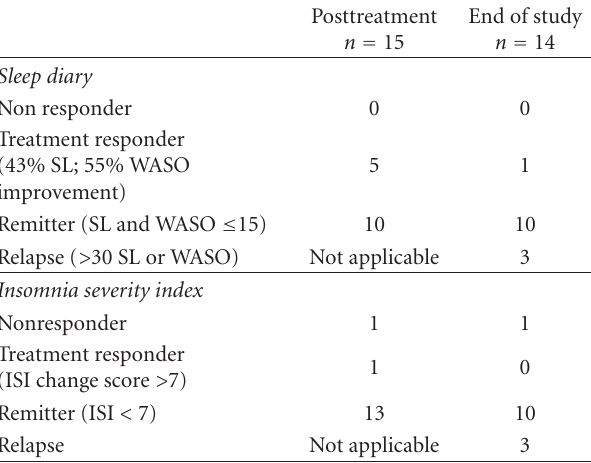
Table 4: Response of subjects completing all